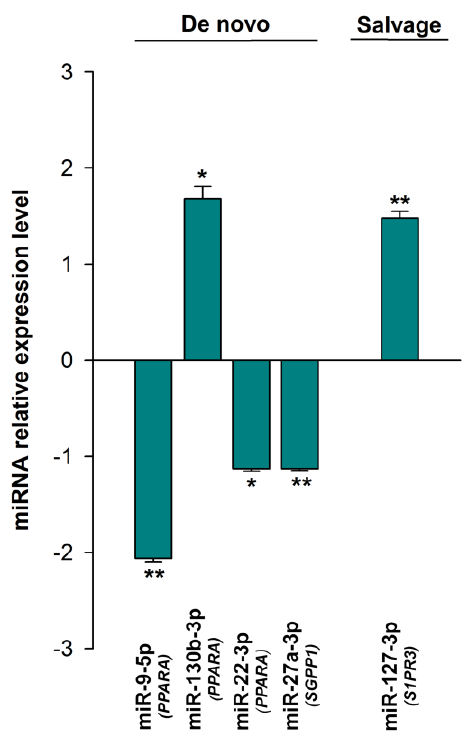
Figure 2. Differential expression of the miRNAs involved in the post-transcriptional regulation of sphingolipid metabolism grouped according to the metabolic pathways of their targets: de novo and salvage pathways. The values from the controls ( n = 8) were set to 1. Data are presented as the fold change ± standard error. Heart failure patients (HF, n = 42; green bars). Mann–Whitney U test: * p < 0.05, ** p < 0.01 vs. the control group. In parentheses are the target genes for each miRNA.